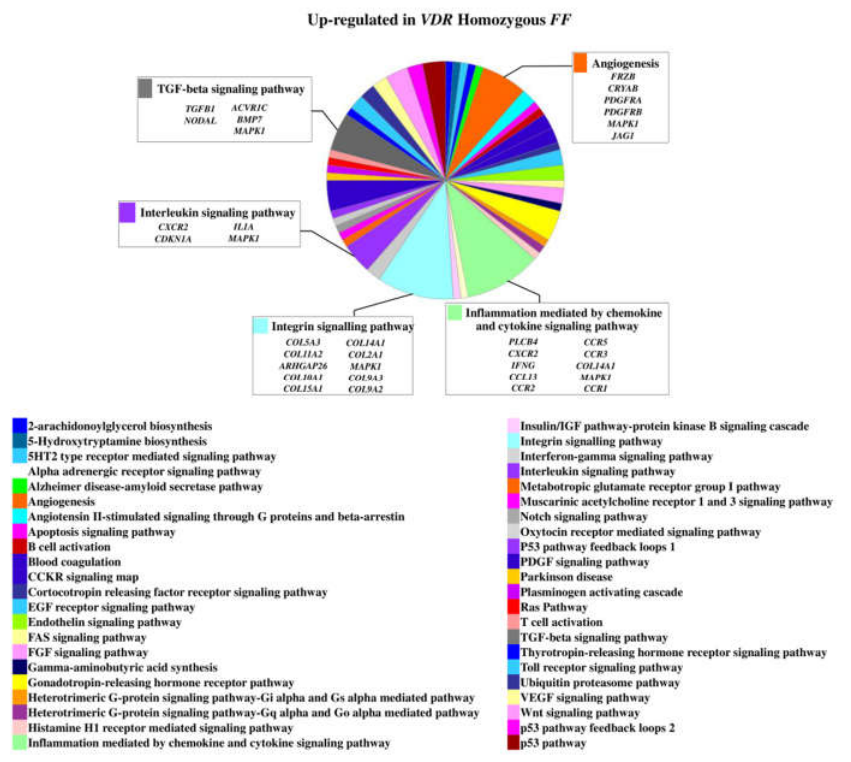
Figure 1. Upregulated genes and related pathways in homozygous FF disc cells. Pie chart obtained by Panther.